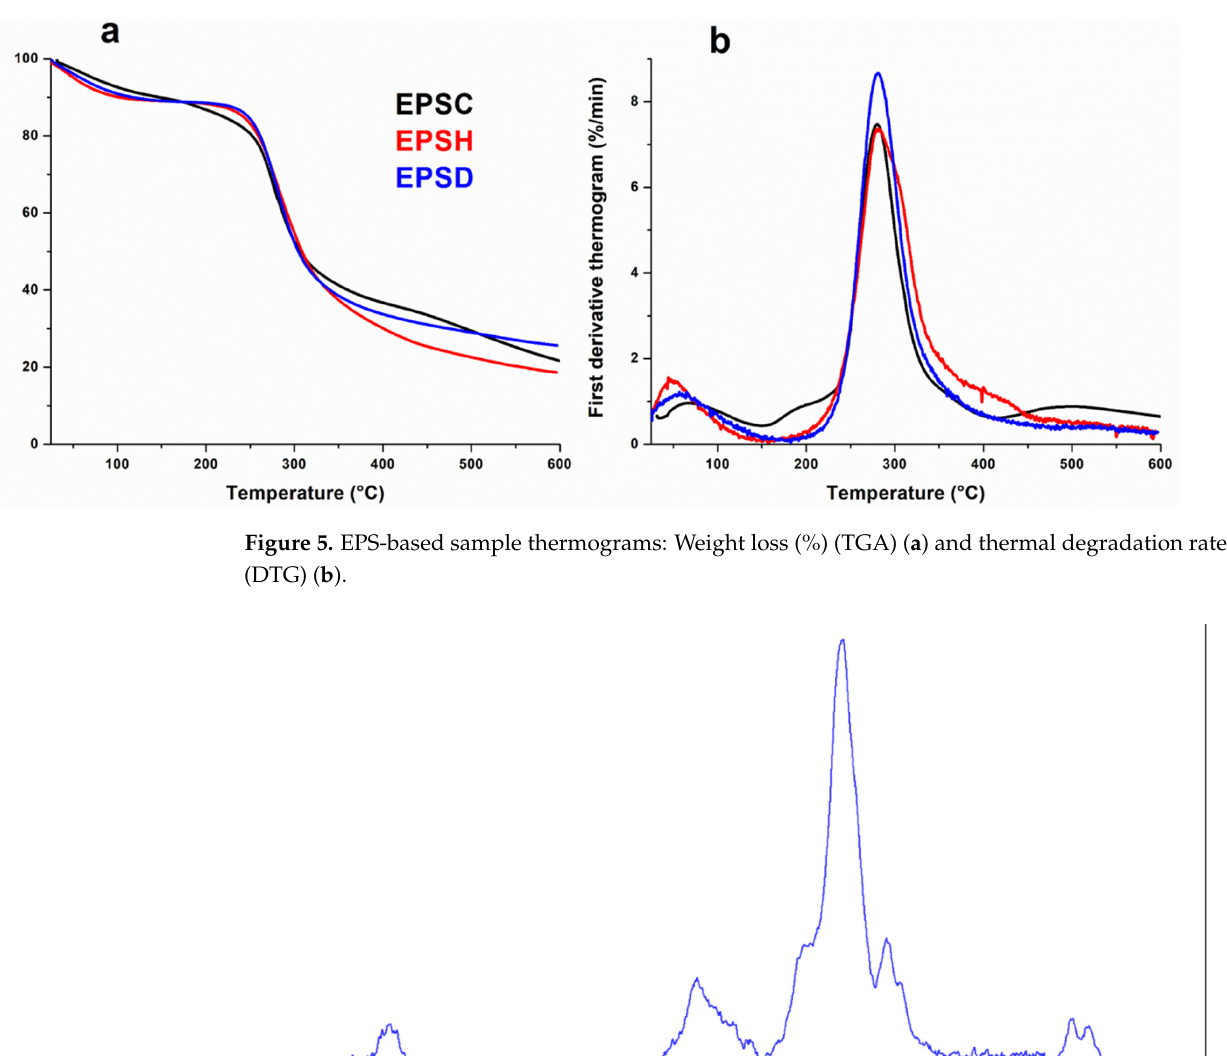
Figure 6. 13 C CP-MAS ssNMR spectrum of EPSC recorded at 400 MHz.